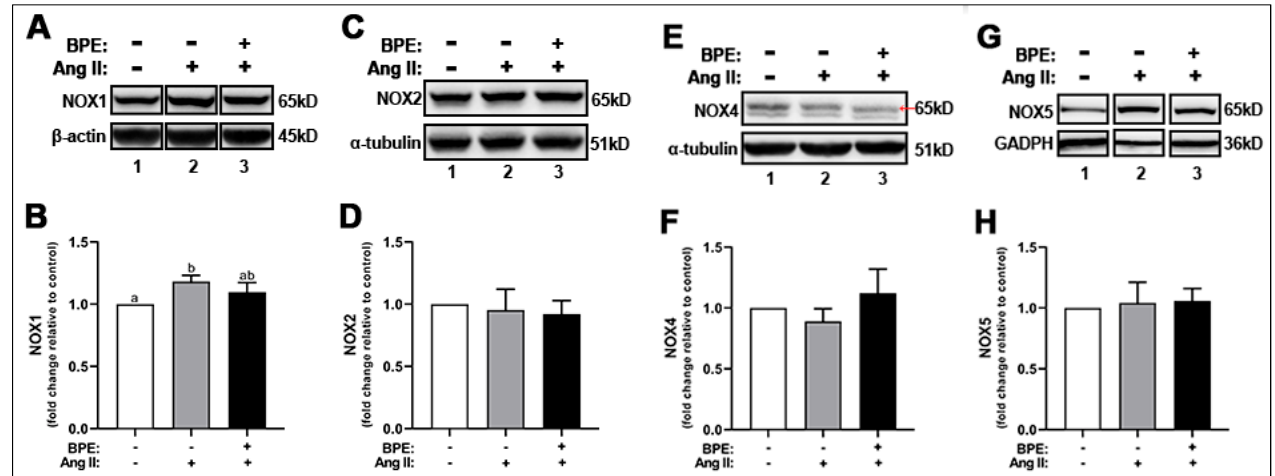
Figure 3. Blueberry polyphenol extract (BPE) did not affect the expression of NADPH oxidases (NOX) in angiotensin (Ang) II-treated human aortic endothelial cells (HAECs). HAECs were treated with 200 µg/mL of BPE for 1 h then treated with 200 nM of Ang II for 12 h. Protein expression of NOX1 ( A , B ), NOX2 ( C , D ), NOX4 ( E , F ), and NOX5 ( G , H ) were determined by Western blot. Quantification was performed using Image Lab (Bio-Rad Laboratories, Inc.). Data are expressed as mean ± SD from three (NOX1 and NOX4) and five (NOX2 and NOX5) independent experiments. Values that do not share the same letter are significantly different from each other ( p ≤